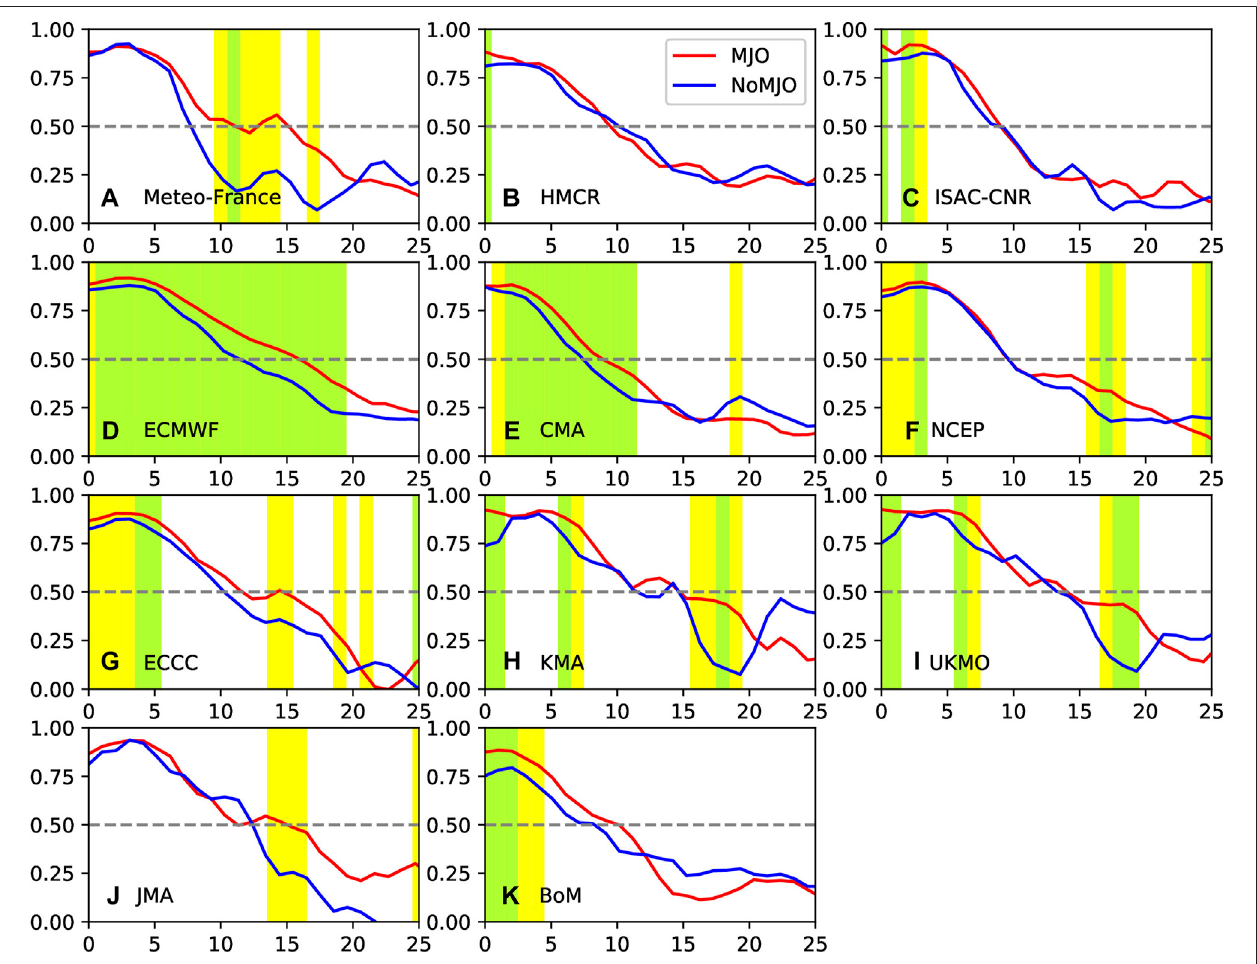
FIGURE4| ArcticOscillation(AO)predictionskillofthe11sub-seasonaltoseasonal(S2S)modelsduringthe fi rst25forecastdayswhentheArcticOscillation(AO)isin the positivephase onthe initial day. Thepredictionskill isthe correlation between the predicted and observedAOwiththe seasonalcycle being removed. Ineachpanel,the red (blue) line indicates prediction initialed with (without) an active Madden – Julian Oscillation (MJO), and the legend is presented in panel B . The gray dash line presents the predictionskillof0.5,above(below)whichtheskillis(not)useful.Thesigni fi canceofthedifferencesbetweenthepredictionskillwithandwithouttheMJO(redandblue lines)ispresentedusingshadingareas.Thegreen(yellow)shadingindicatesthatthesigni fi canceisatthe5%(10%)levelaccordingtothemethodintroducedinthe Signi fi cant Test section. Panel (A-K) are for models of Meteo-France, HMCR, ISAC-CNR, ECMWF, CMA, NCEP, ECCC, KMA, UKMO, JMA, and BoM, respectively.